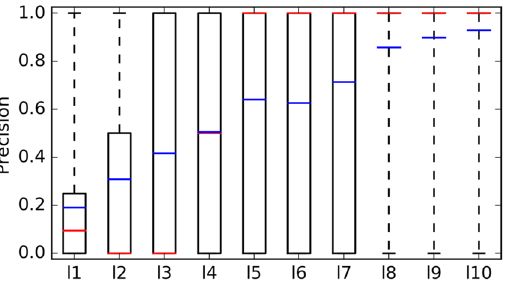
Figure 2. Boxplot showing how the precision of predicted targets varies depending on L (NB: l1 is l = 1 and corresponds to L = 0.1). The mean precision for a given L is marked with a blue line, whereas the median is given by a red line.